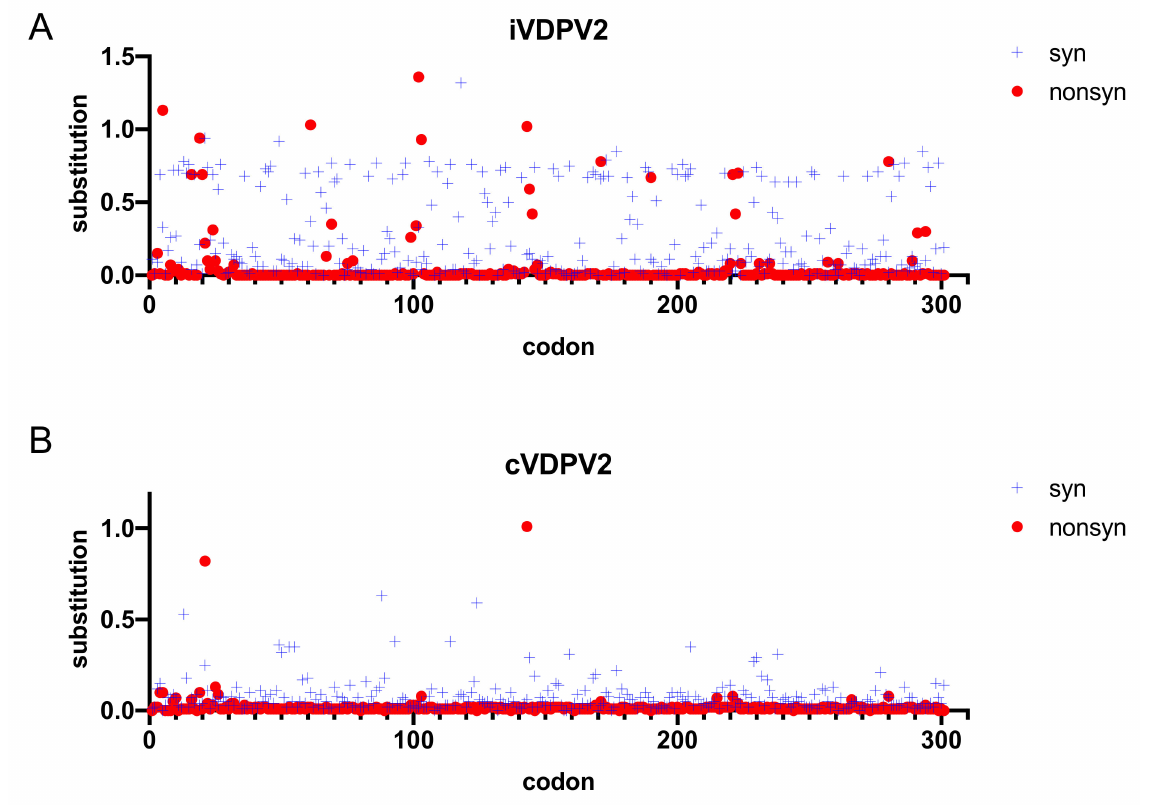
Figure 2. The frequency of synonymous and non-synonymous substitutions of the VP1 amino acid sequences from 157 iVDPV2 and 567 cVDPV2 isolates. Sequence divergence was analyzed using SNAP (Synonymous Non-synonymous Analysis Program, https://www.hiv.lanl.gov/content/sequence/SNAP/SNAP.html (accessed on 28 May 2021)) [54]. The synonymous (blue crosses) and non-synonymous substitutions (red circles) of the VDPV sequence relative to the Sabin 2 strain are depicted. ( A ) iVDPV2. ( B ) cVDPV2.